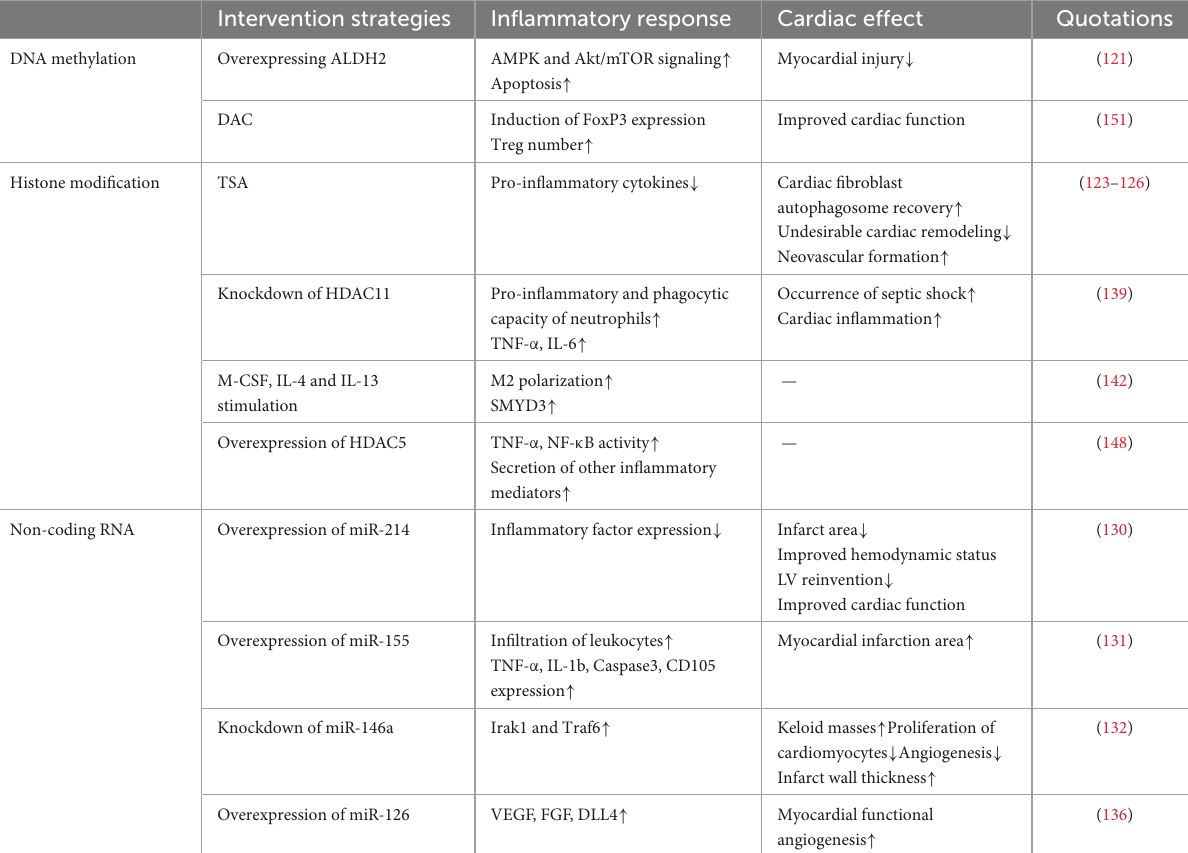
TABLE 2 Experimental evidence that epigenetic modifications modulate inflammatory responses affecting cardiac